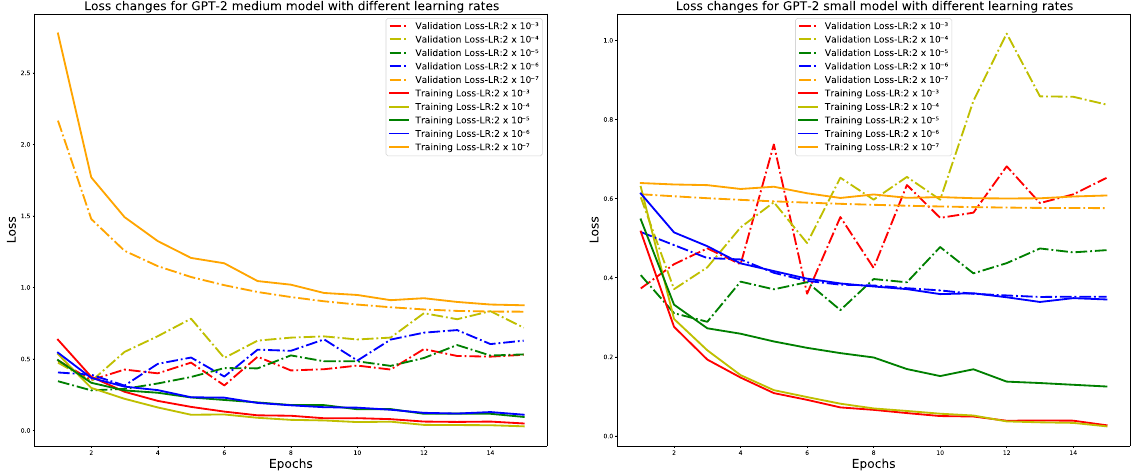
Figure 9. Loss changes for GPT-2 models with different learning rates: GPT-2 medium ( left ) and GPT-2 small ( right ) for 15